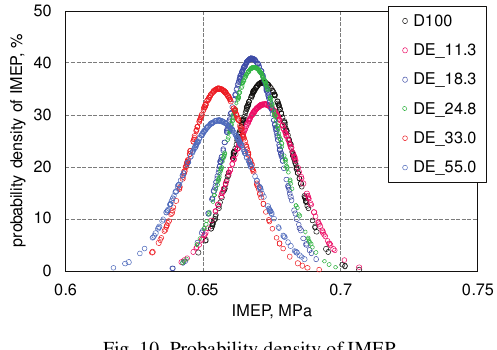
Fig. 10. Probability density of